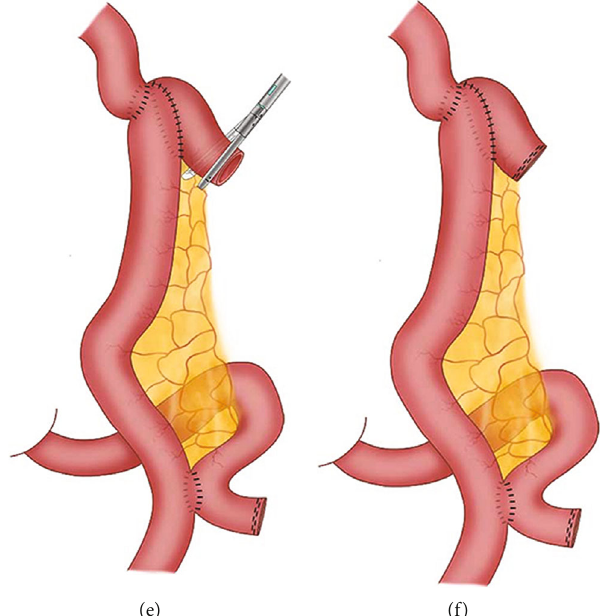
Figure 2: Schematic diagram of pant-shaped anastomosis. A purse-string suture was made on the antimesenteric edge 10 cm away from the jejunal end (a), followed by an incision in its center (b). The two arms of a linear stapler were inserted into the a ff erent and e ff erent portion of the jejunum, respectively (c). A circular stapler was inserted into the jejunal pouch through the jejunal end, with the central rod puncturing through the antimesenteric incision (d). After the EJS was fi nished, the remnant entry was closed using a linear stapler (e), which left the fi nal appearance of the anastomosis similar to a pair of low crotch pants